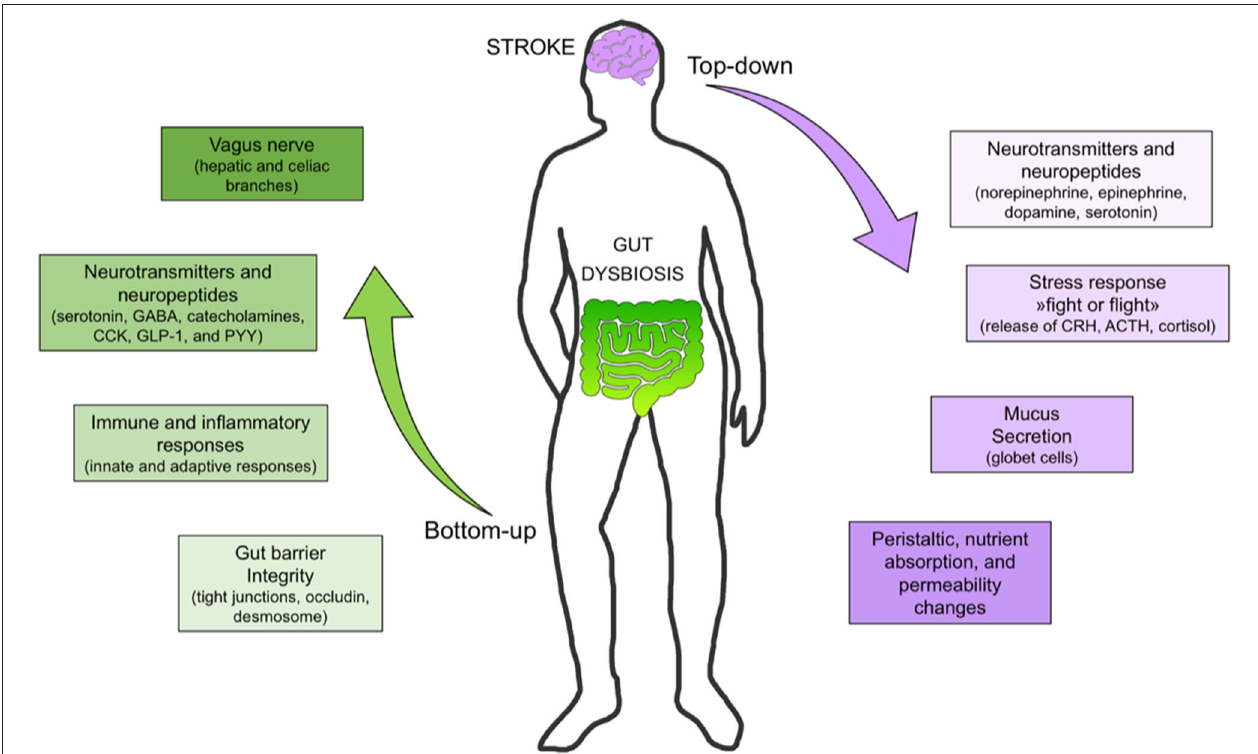
FIGURE 1 | Bottom-up and top-down signaling in stroke. Bottom-up signaling from the gut to the brain includes barrier integrity maintenance, immune response (e.g., immunoglobulin A secretion), neurotransmitter and neuropeptide release, short-chain fatty acid (e.g., butyrate) release, and vagus nerve activation. Top-down signaling includes release of neurotransmitters (e.g., dopamine, serotonin), stress response (e.g., cortisol release), mucus secretion, and peristalsis control. [SCFA, short chain fatty acid; DA, dopamine; 5HT, serotonin; Ig, immunoglobulin, PYY, peptide YY; GLP-1, glucagon-like peptide-1; CKK, cholecystokinin; GABA, gamma amino butyric